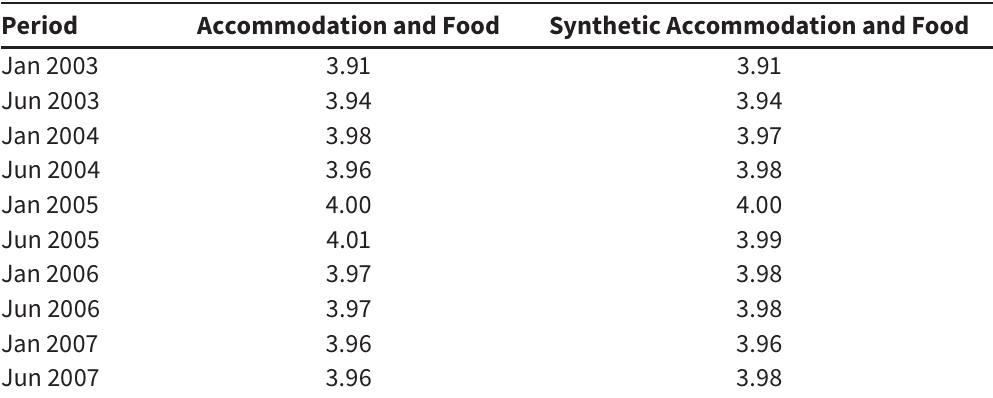
Pre-Treatment Log Employment in Actual and Synthetic Accommodation and Food Industry (USA Donors)